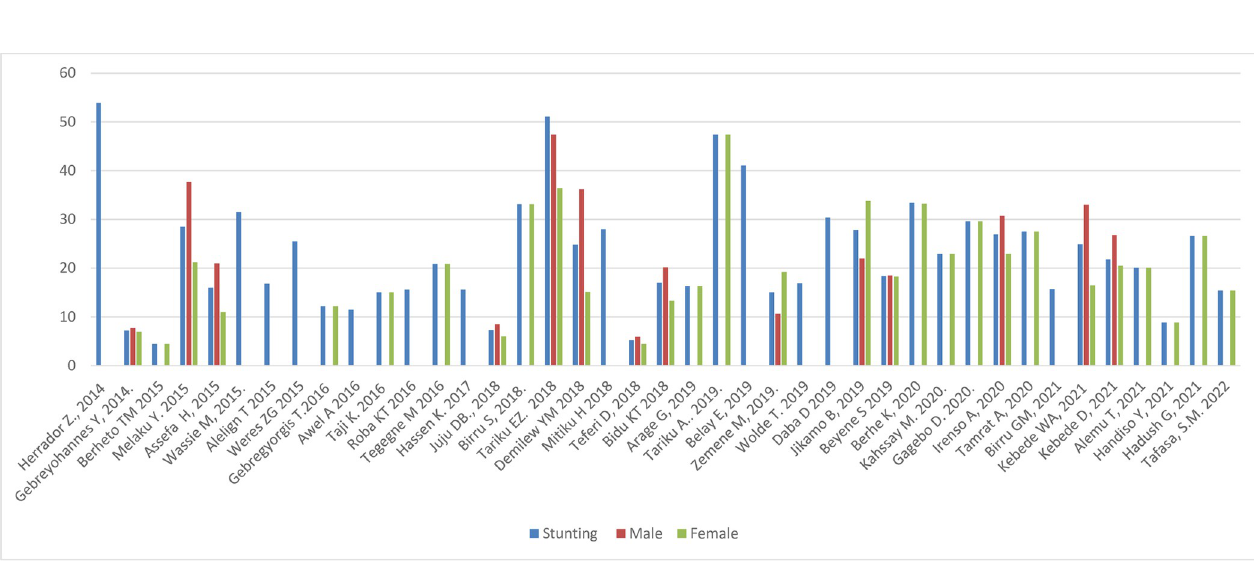
PLOS ONE | https://doi.org/10.1371/journal.pone.0280784 April 6,